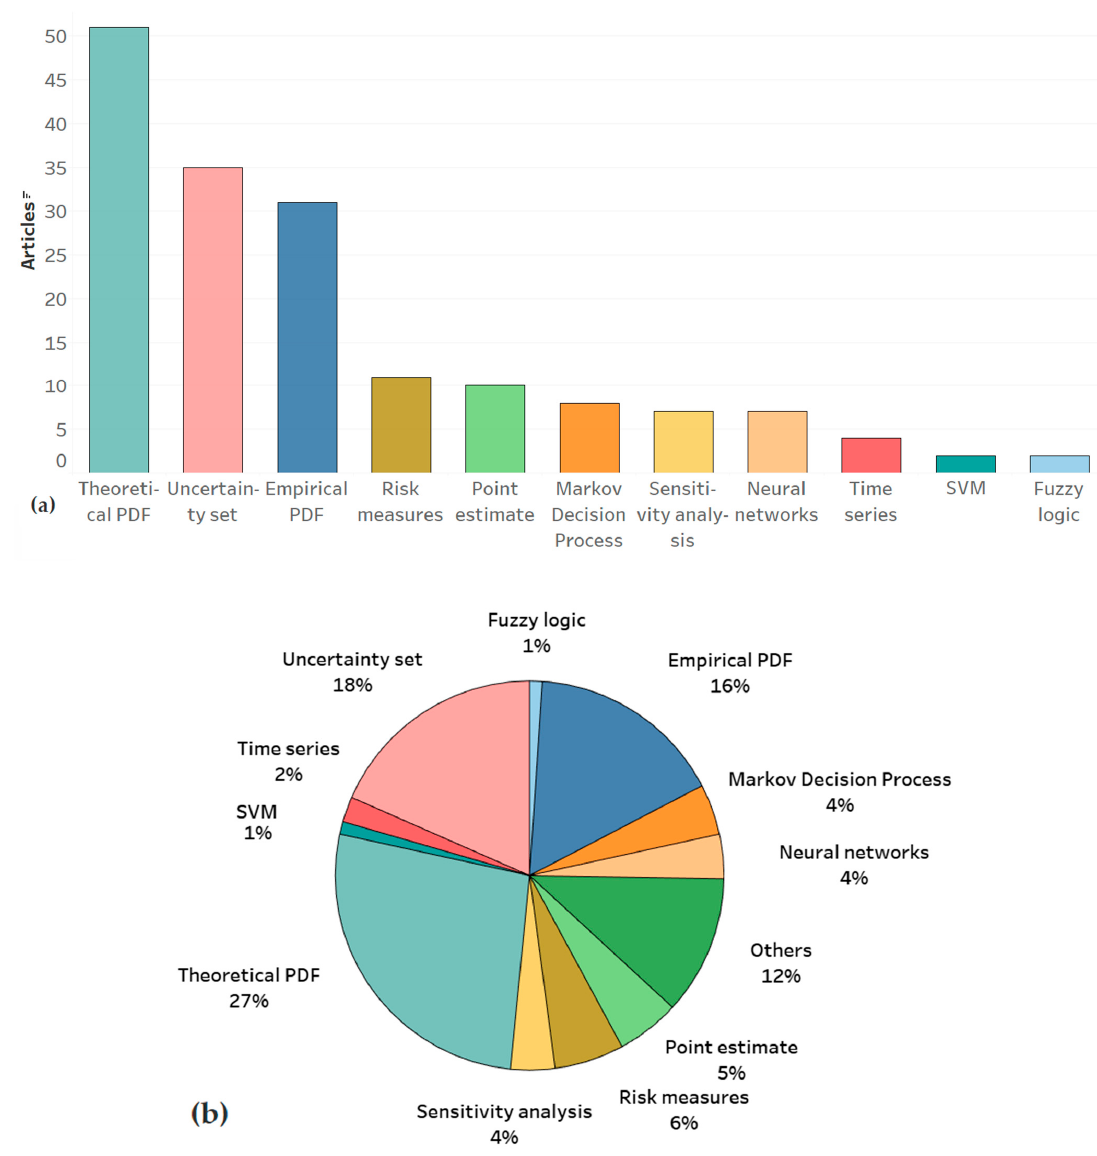
Figure 4. ( a ) Number of articles that consider each uncertainty addressing method (UAM). ( b )